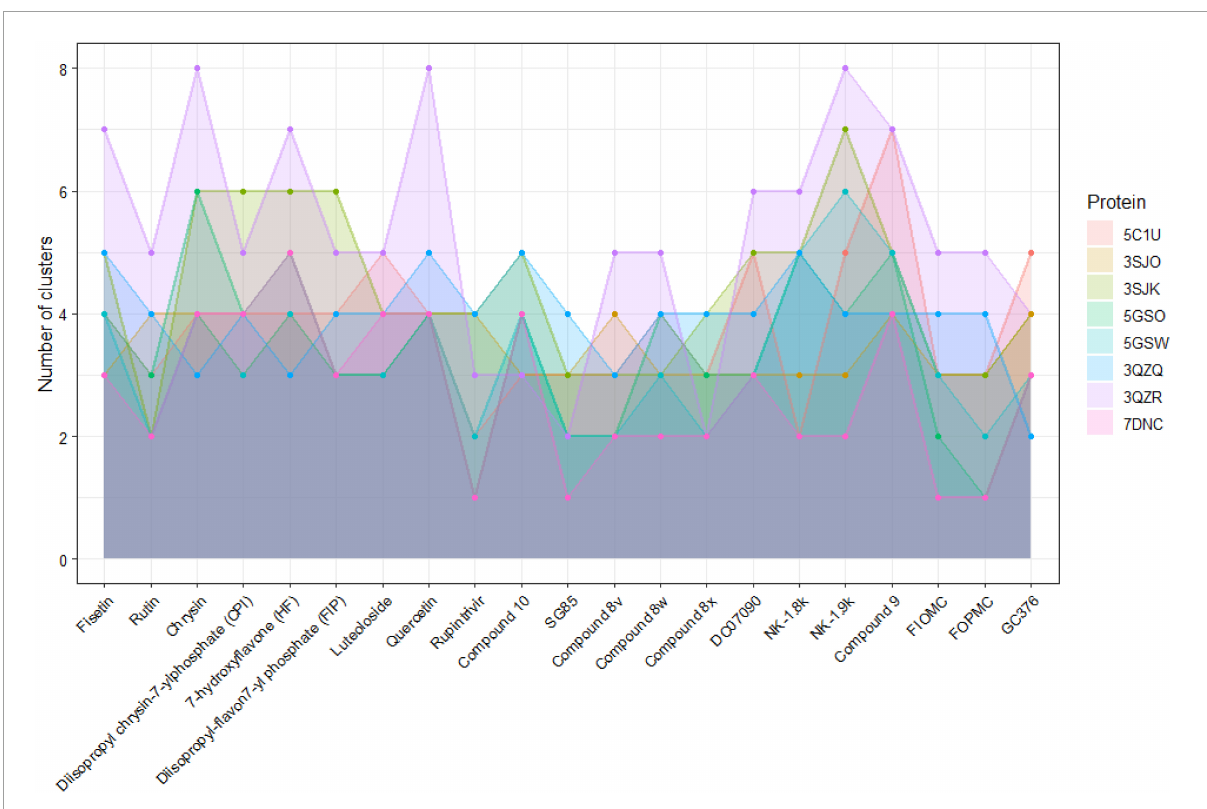
FIGURE6 The number of clusters formed in docking each 21 ligands against each of eight proteins